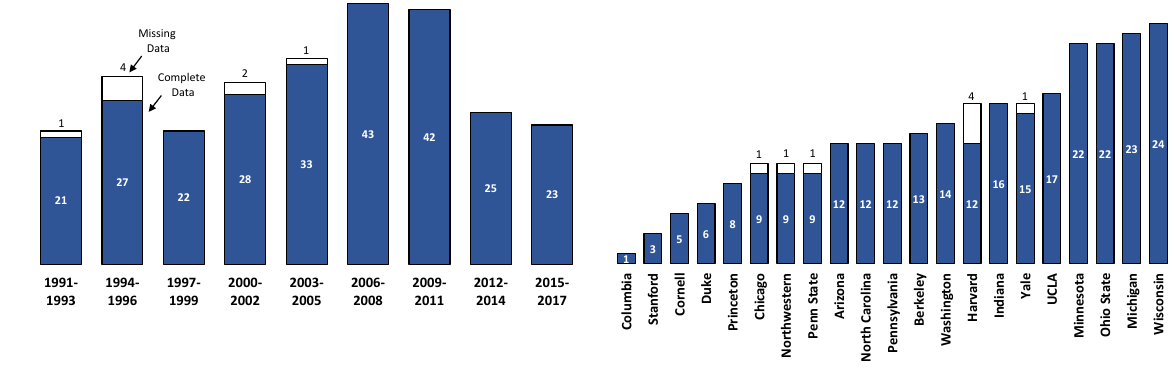
Figure 2: Number of newly promoted associate professors by year and